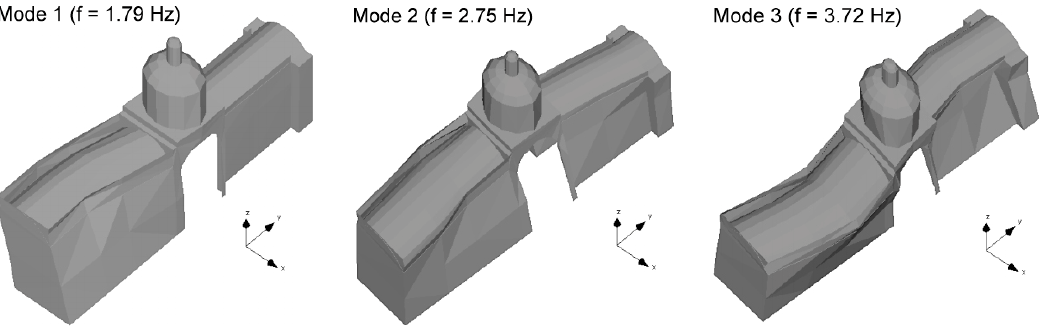
Figure 4. First three modes of vibration estimated by the Stochastic Subspace Identification based on Unweighted Principal Component (SSI-UPC) method.